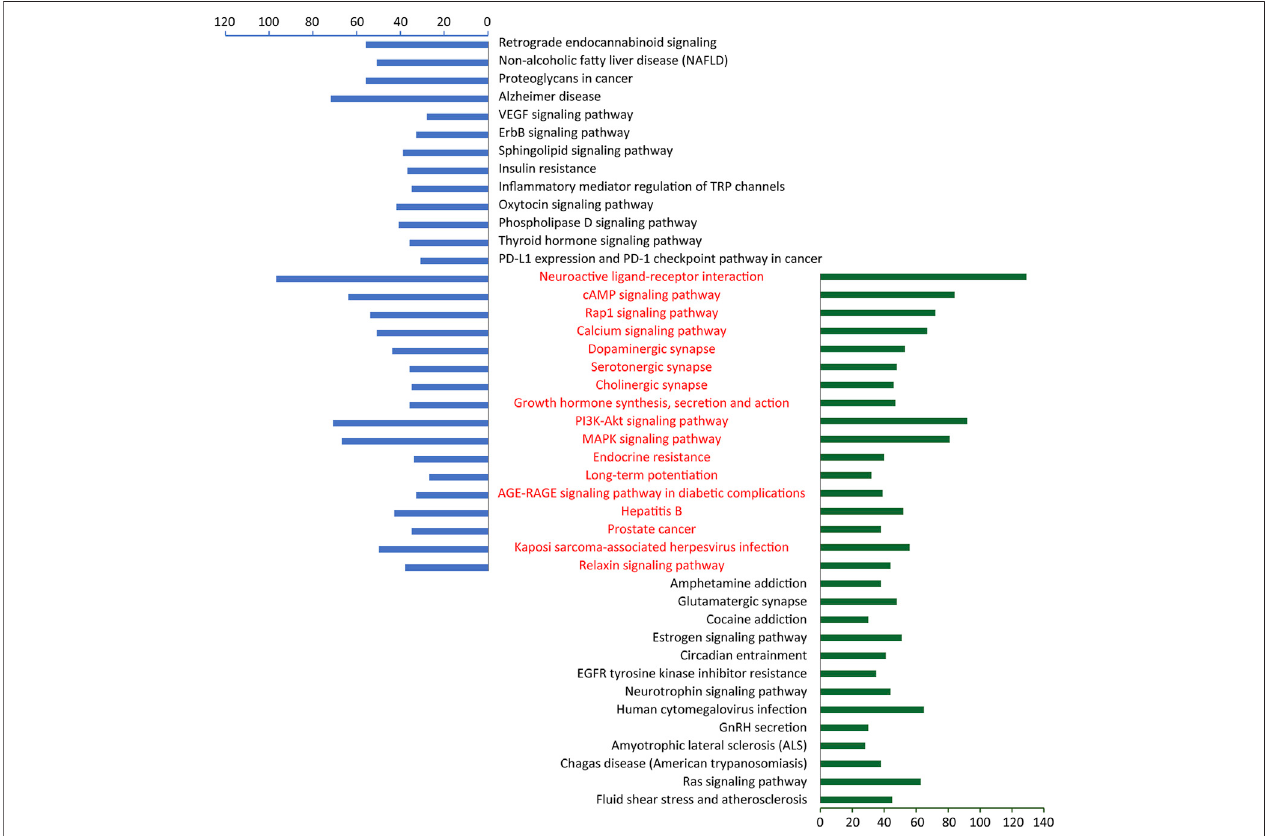
FIGURE 7 | Enriched pathways of CGFC targets and pathogenic genes. The red part represents the shared pathways of CGFC targets and pathogenic genes.